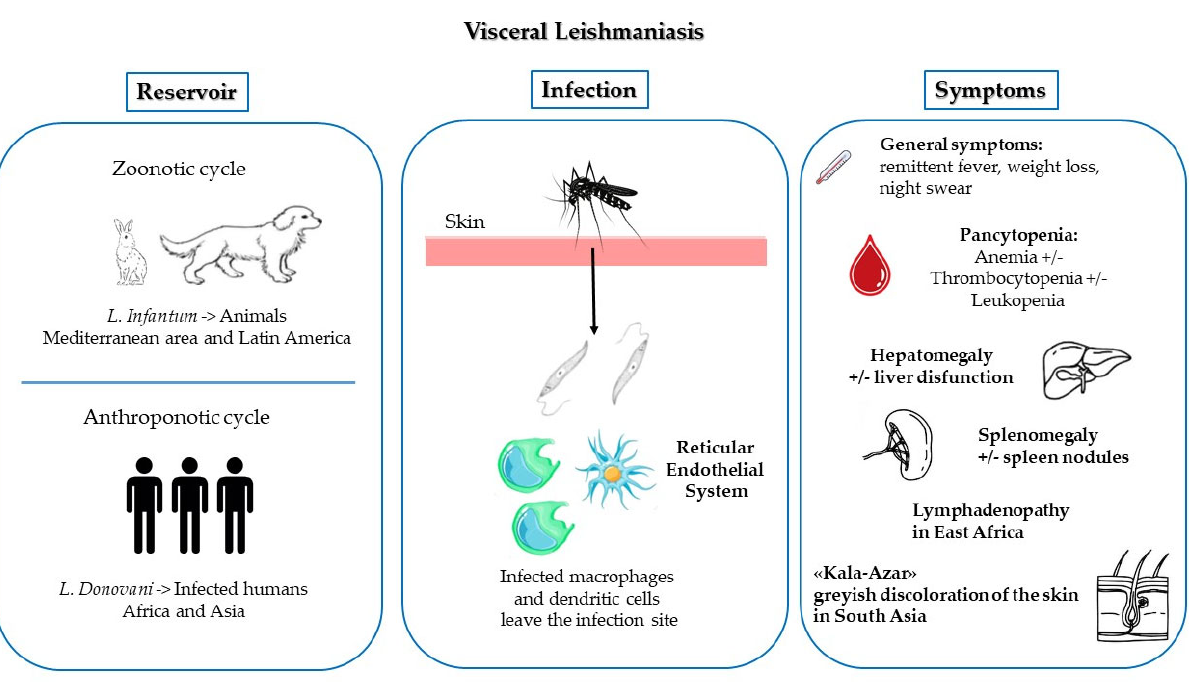
Figure 1. Life cycle of L. infantum and L. donovani and main symptoms of